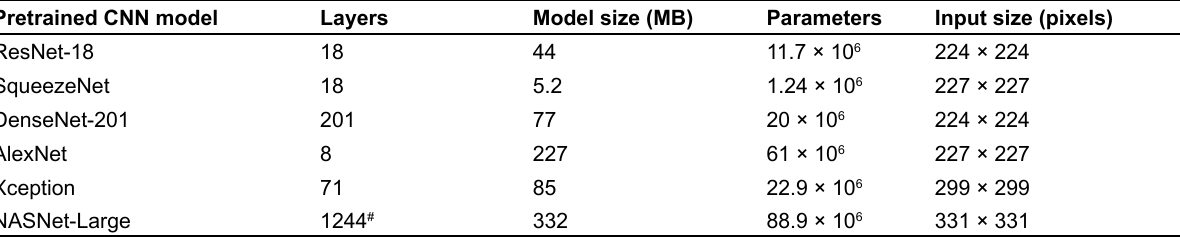
Table 3. Properties of pretrained networks Pretrained CNN